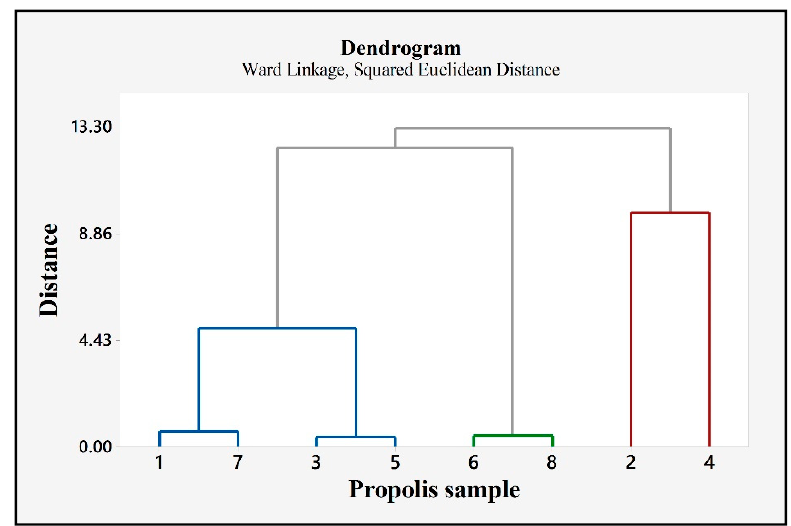
Figure 11. Hierarchical cluster analysis of the samples.